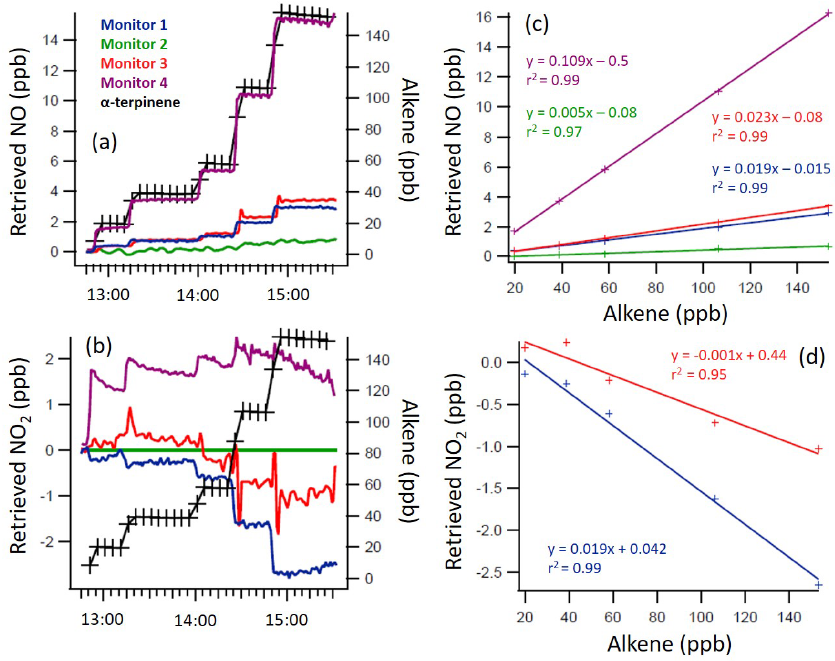
Figure 2. Time series of the α -terpinene mixing ratio and indicated/measured NO (a, c) and NO 2 (b, d) mixing ratios, as directly retrieved by each monitor (a, b) , with 1min time resolution, and the regression calculations for the monitors that demonstrated significant interference with the addition of α -terpinene (c, d) . Note the different y axis scales.